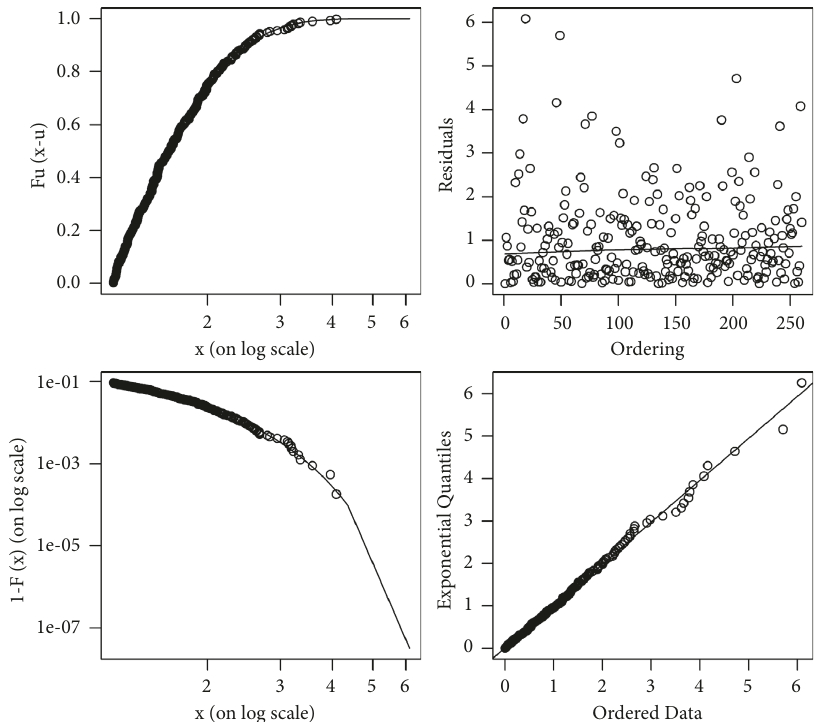
Figure 9: Palm oil negative returns GPD fitted diagnostic plots.